Question: Briefly state, in one sentence, what is plotted here.
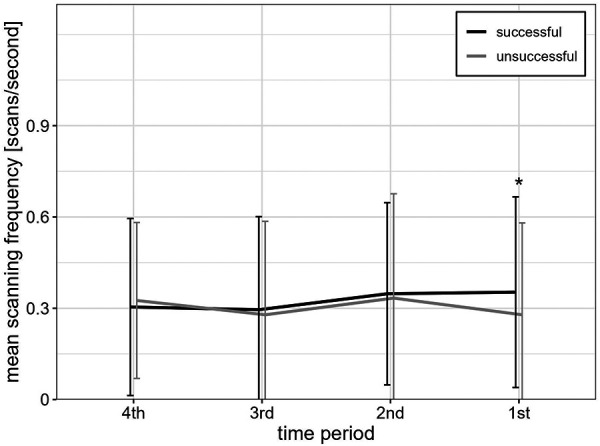
Answer: Mean scanning frequency for each time period (1st = 0–2.5s, 2nd = >2.5–5s, 3rd = >5–7.5s, 4th = >7.5s–10s) and subsequent action success. Significant differences between successful and unsuccessful subsequent actions within the respective time periods are marked (* p < 0.05).